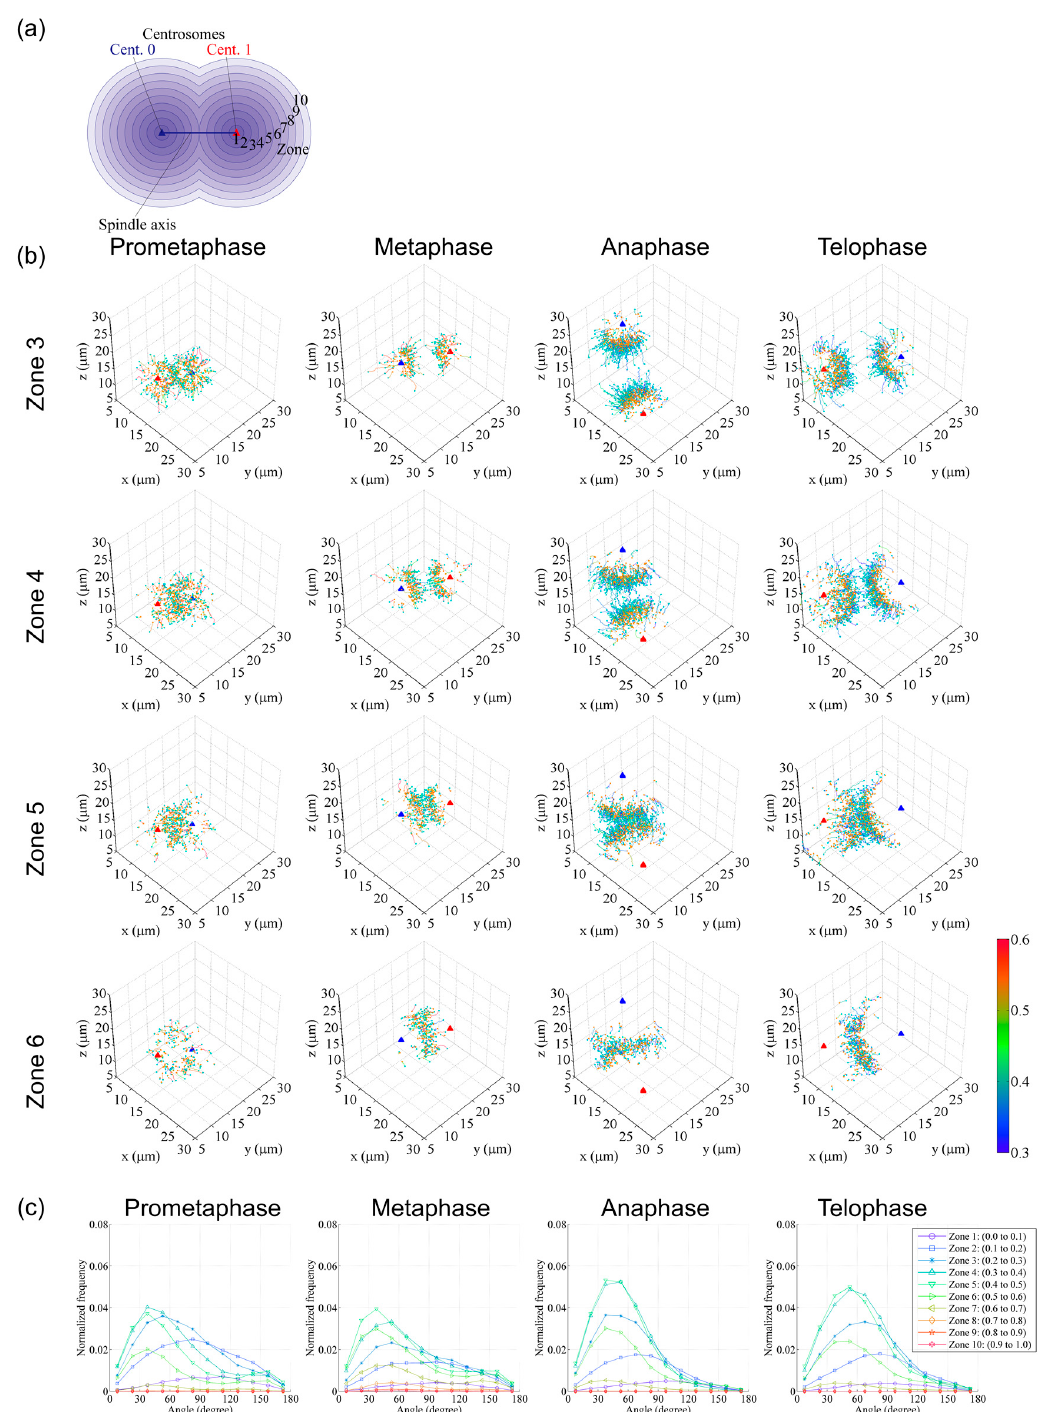
Figure 5. Examples of digital spindle analysis (continued). ( a ) To classify trajectories according to the start position, a spherical classification bin (zone) was set. Spheres centered at centrosomes (red and blue triangles) and with radii equal to the intercentrosomal distance were generated, and then divided into 10 spherical zones of equal radial length. ( b ) Trajectories starting at each zone were extracted and plotted in 3D coordinate systems. The trajectories are shown with colors corresponding to the average speed of each trajectory, with orange dots at the start of the trajectory and cyan dots at the end. The colored bar indicates the mean speed ( µ m / s). ( c ) The travel angle of each comet against the spindle axis was analyzed and plotted for each zone. Data are reused from [12]. Plots in ( b , c ) were generated using custom tools created in Matlab.